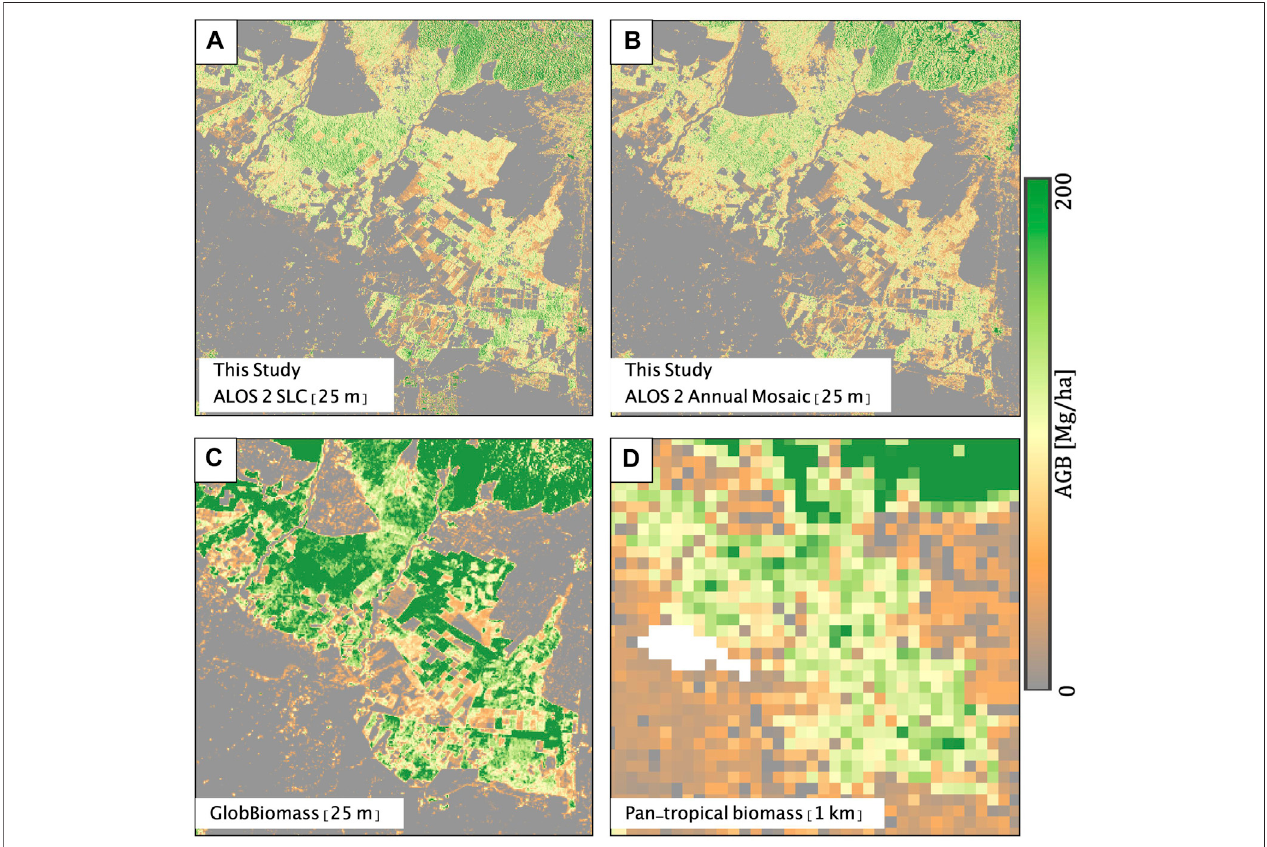
FIGURE 12 | The AGB maps generated using the multitemporal mean AGB of (A) 23 ALOS-2/PALSAR-2 SLC acquisitions and (B) yearly ALOS-2/PALSAR-2 global mosaics. The generated AGB maps are compared with available AGB maps from (C) GlobBiomass (Santoro, 2018) and (D) pan-tropical AGB (Avitabile et al., 2016). The pan-tropical AGB is at 1 km resolution while the other maps are generated at 25 m